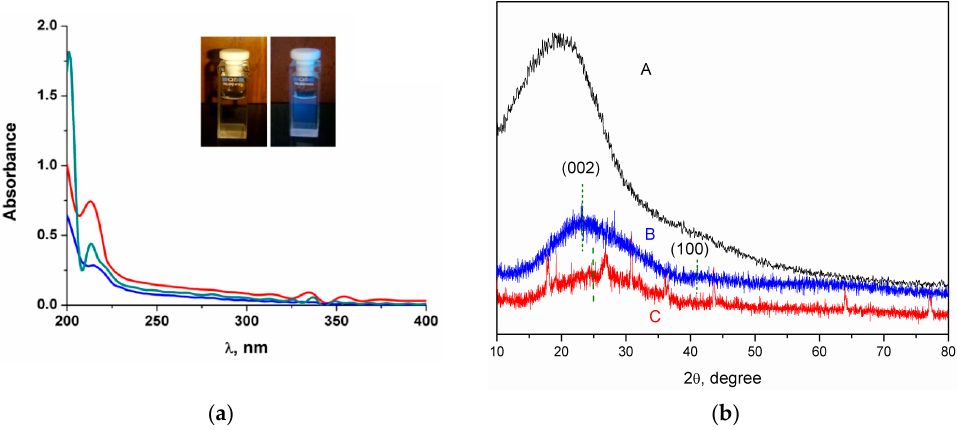
Figure 3. ( a ) The UV-vis absorption spectra for CQD 180-4 (blue), CQD 180-12 (green) and CQD 200-4 (red) samples; ( b ) the XRD pattern of humins (A), CQD 200-4 (B) and CQD 180-12 (C). The UV absorption band at 220 nm is attributed to the π - π * transition of the C=C bonds with a tail extending into the visible range (Figure 3a). The relatively weak ab- sorptions at 335 and 354 nm may originate from the n– π * transition of the C=C-C=O groups (335 nm) and from the overtone transition of the oxygen bridged bond (R-O-R ′ ) (354 nm) in the sp 3 hybrid region. The XRD pattern (Figure 3b) of CQDs revealed two diffraction lines centered at 22 and 42 ° , indicating a graphite-like carbon structure in their core [35]. For the CQD 180-12 , the lower diffraction line intensity along with a rela- tively high full width half maximum suggest the presence of particles with a smaller size [34].